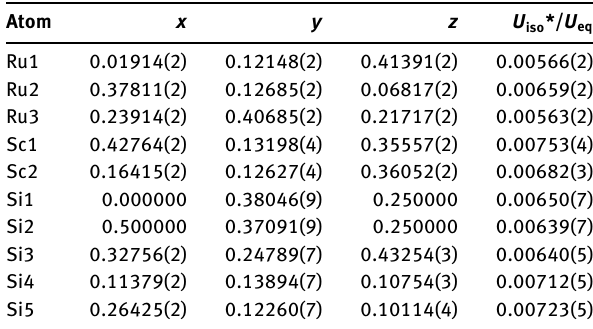
Table 2: Fractional atomic coordinates and isotropic or equivalent isotropic displacement parameters (Å 2